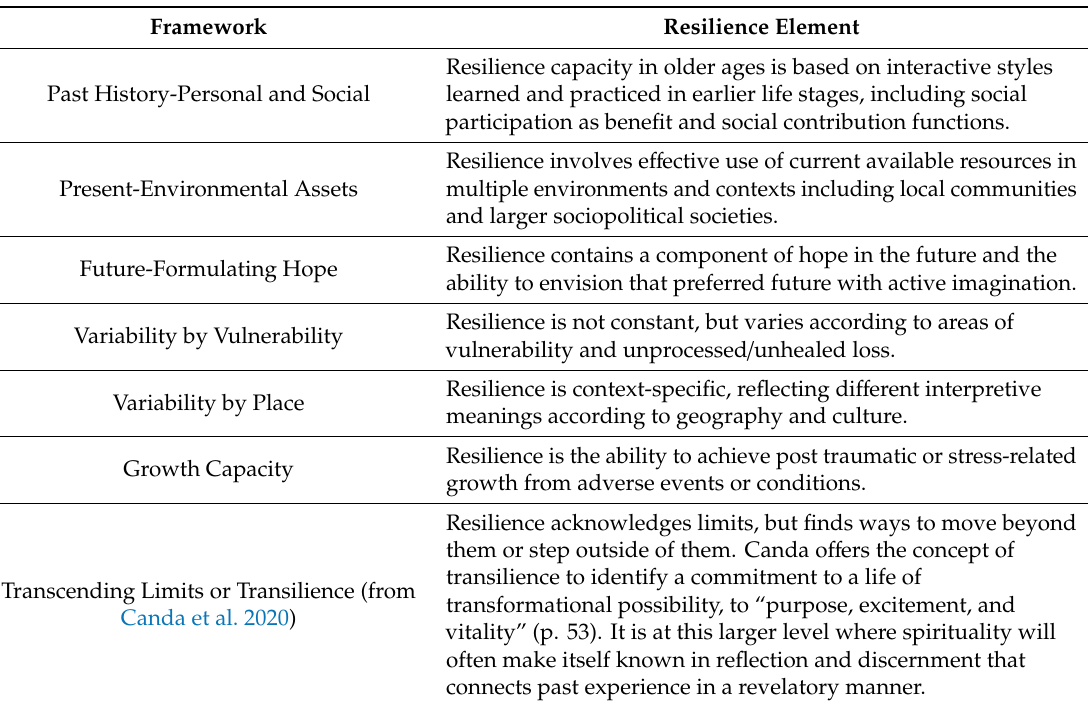
Table 1. Resilience Properties in